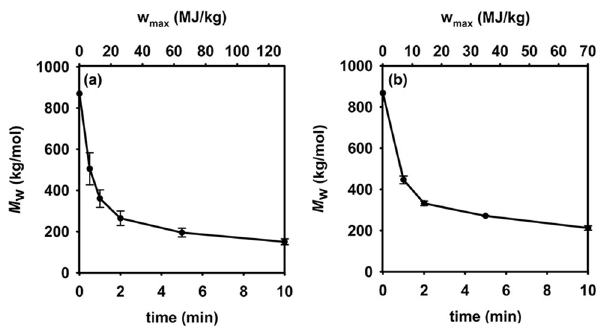
Fig. 3 Changes in molar mass with sonication. Plots of weight-average molar mass ( M w ) versus time and maximum speci fi c energy ( w max ) for sonicating PAA P&G at a 2.5% w/v and b 5.0% w/v. Error bars are derived from an average of two